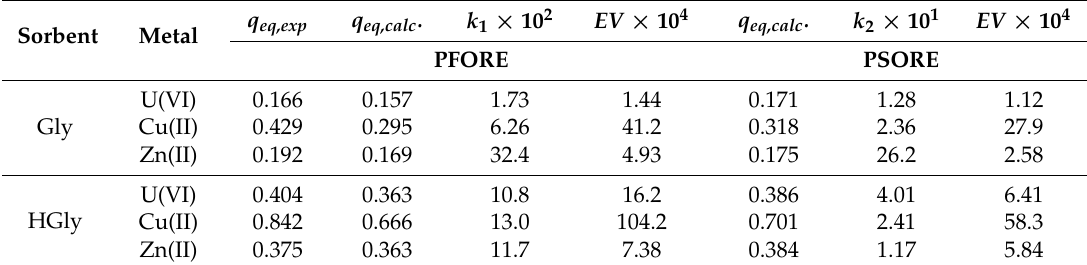
Table 2. Uptake kinetics for U(VI), Cu(II), and Zn(II) recovery using Gly and HGly sorbents—Modeling with the PFORE and the